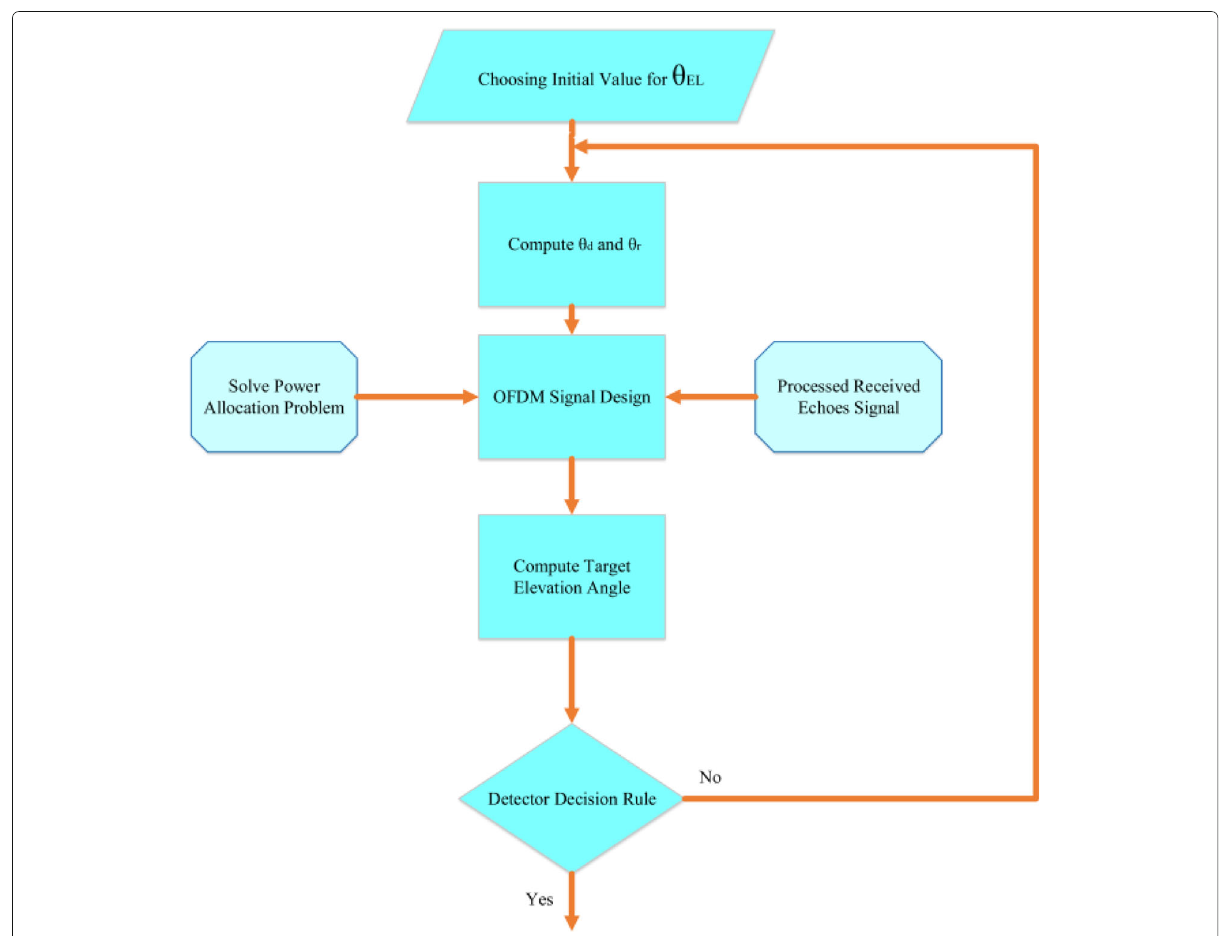
Fig. 2 Flowchart of the proposed OFDM signaling scheme for low grazing angle target tracking